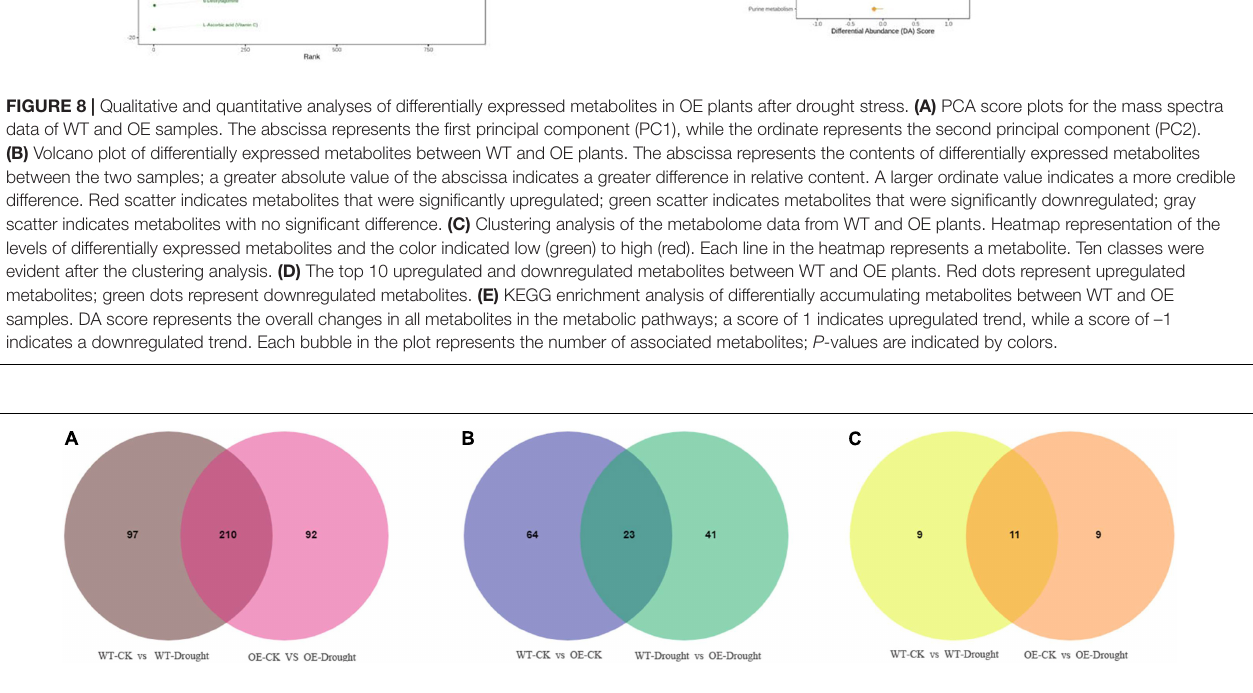
FIGURE 9 | Venn diagrams of differentially accumulated metabolites (DAMs). (A) Venn diagram showing common DAMs between normal and drought conditions in WT and OE plants. (B) Venn diagram showing unique and common DAMs between WT and OE plants under normal and drought conditions. (C) Venn diagram showing common DAMs in the top 20 differentially expressed metabolites in WT and OE plants after drought stress.